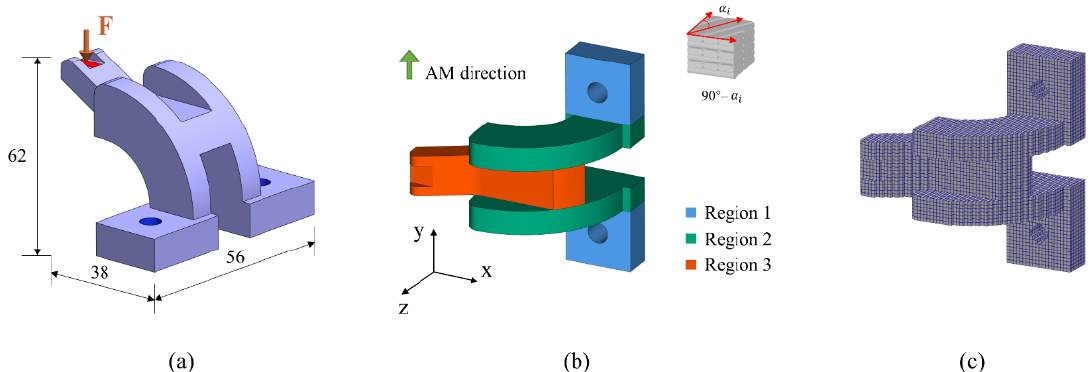
Figure 10. Illustration of the first example. ( a ) The dimension and boundary conditions of the bracket; ( b ) the AM direction and region divisions; ( c ) voxelization of the bracket. The convergence history of the optimization process is depicted in Figure 11a. The compliance curve eventually converges to 90 ◦ –90 ◦ , 90 ◦ –37 ◦ , and 90 ◦ –49 ◦ distribution in the